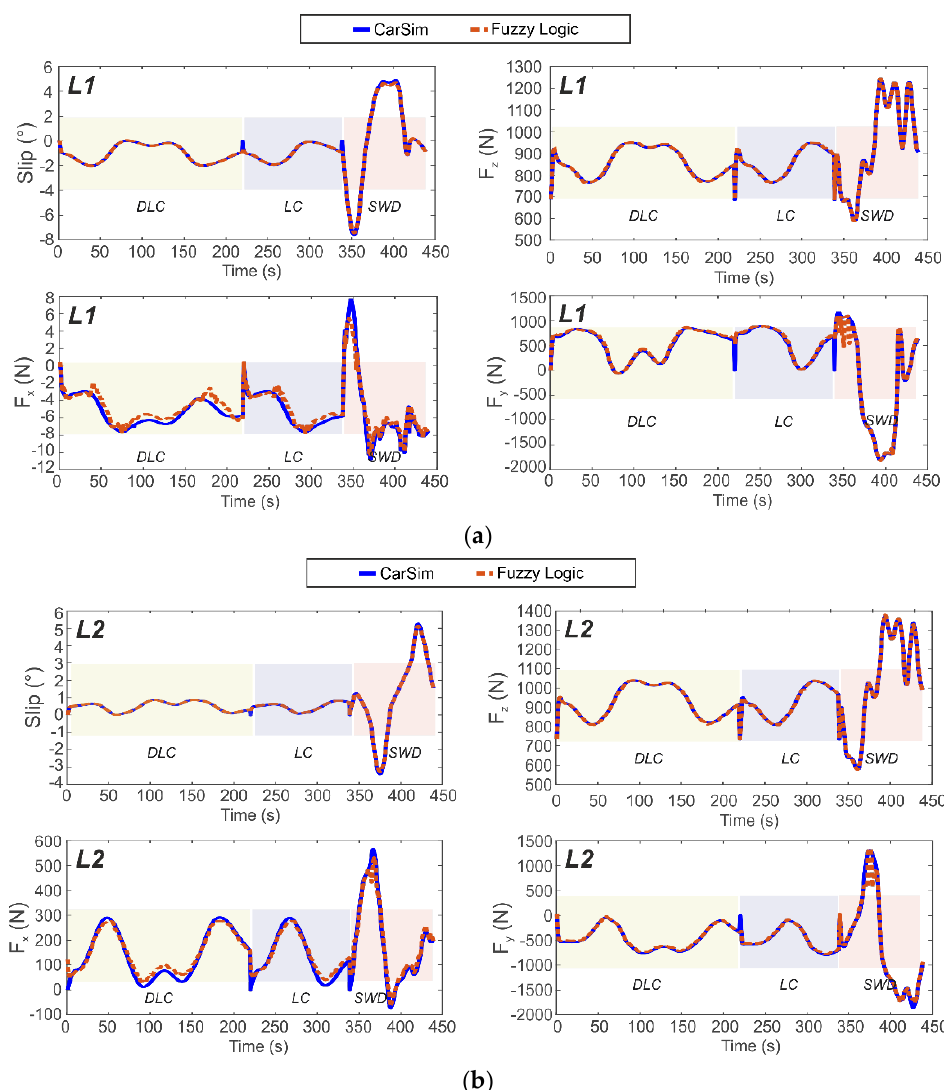
Figure 12. Simulation results for tire ’ s maneuverings at 80 km/h. ( a ) Steered axle, wheel L1 ( b ) Powered axle, wheel L2